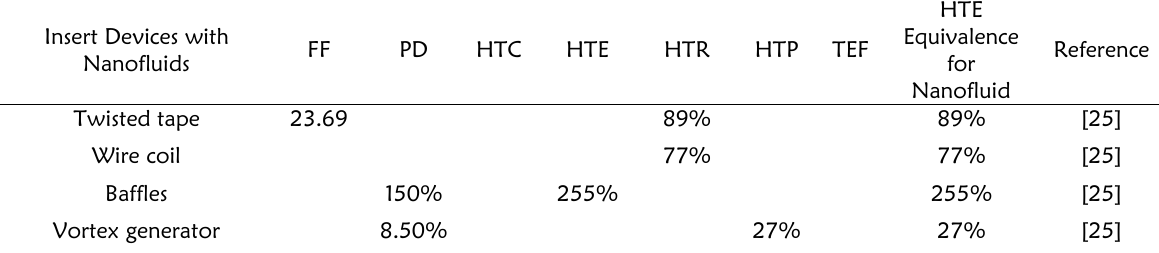
Table 4: Important findings of literature reviews regarding the heat transfer enhancement of various insert devices with nanofluids compared to the corresponding insert device